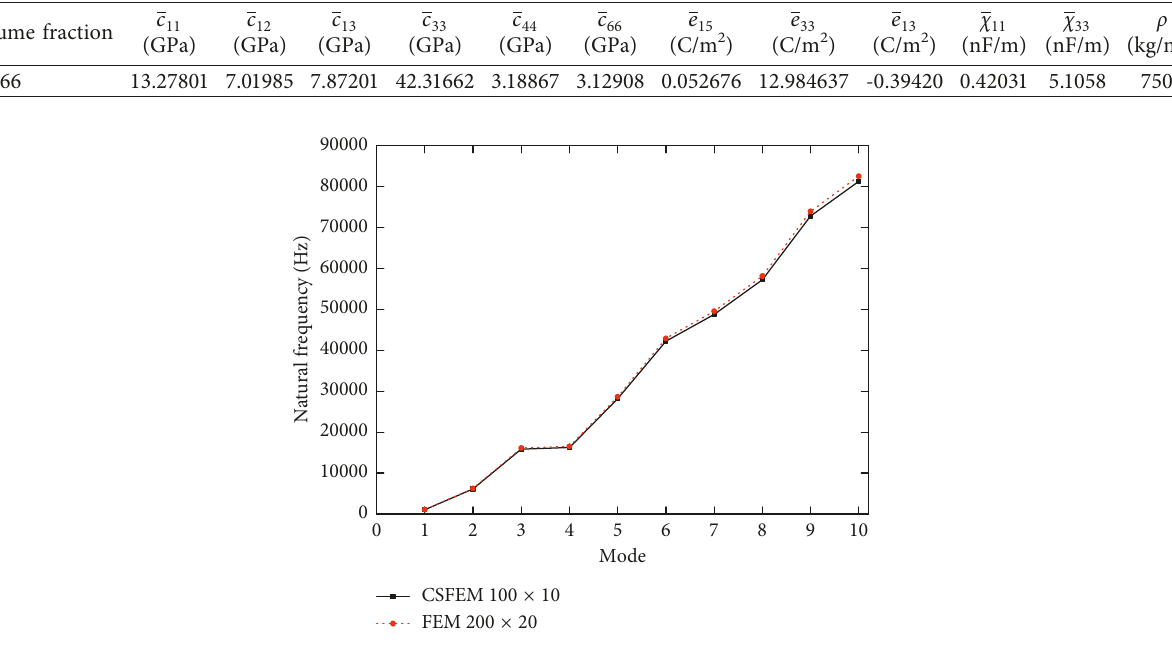
Figure 12: First 10 natural frequencies of the cantilever PCMs beam using CSFEM and FEM.